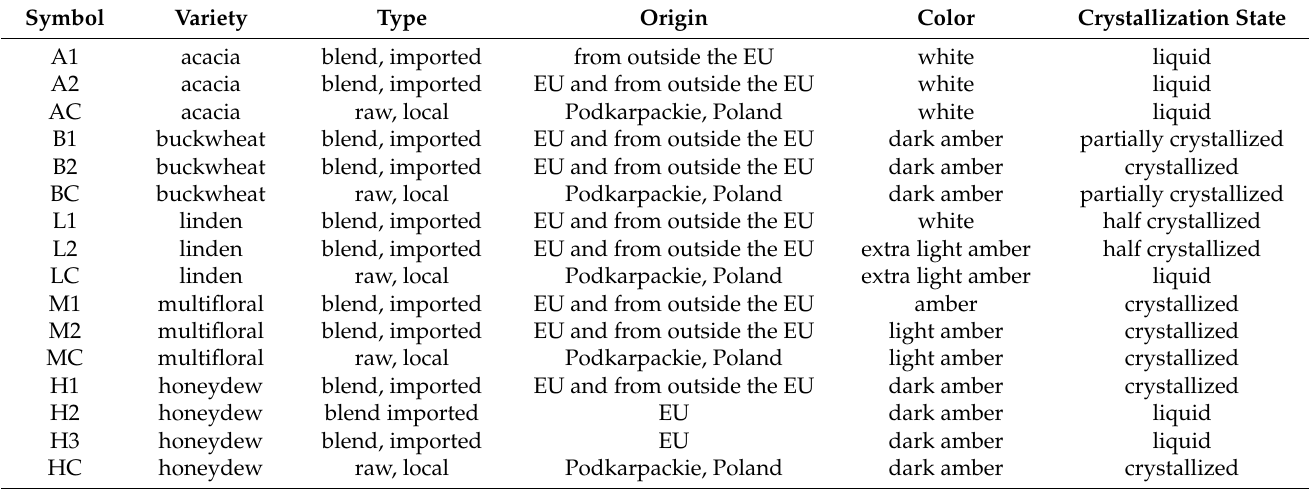
Table 4. List of honeys used for